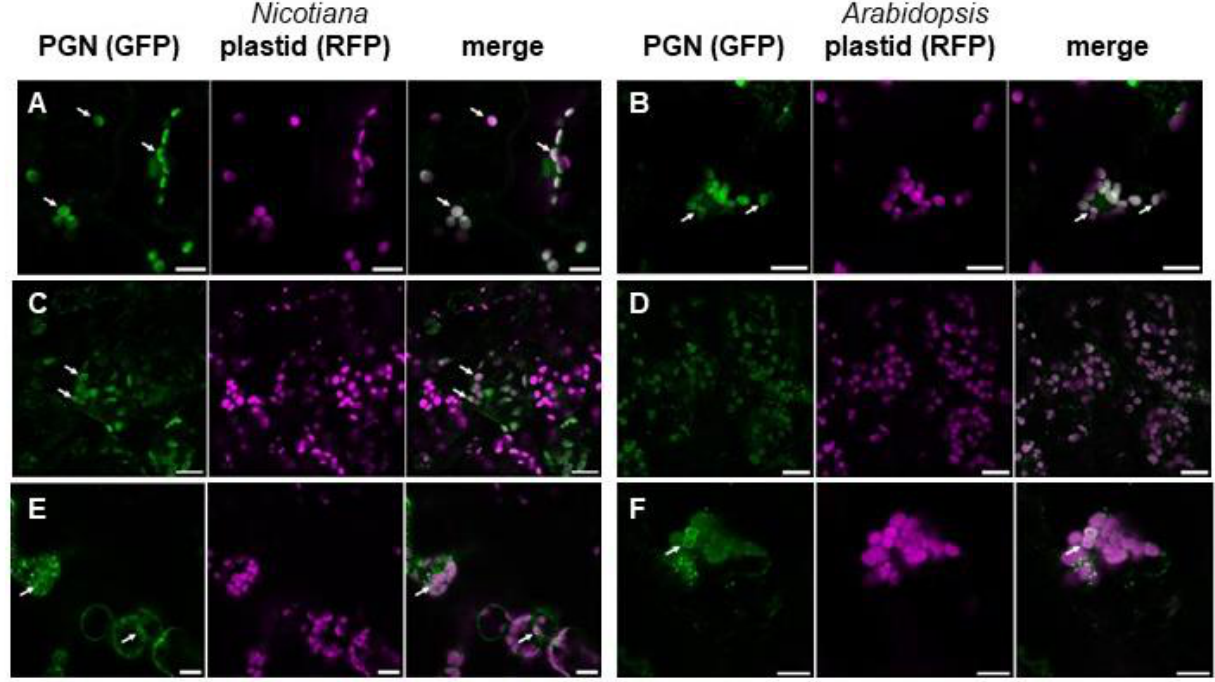
Figure 3. PGN-recognizing proteins localize in and around chloroplasts of Nicotiana and Arabidopsis cells. a-b, Fluorescence microscopic image of Nicotiana cells expressing ( A ) DmPGRP ΔSP -GFP and ( B ) HsPGRP ΔSP -GFP (green) together with a plastid marker (magenta; scale bars 15 µm). ( C , D ) Fluores- cence microscopic image of Arabidopsis cells expressing ( C ) DmPGRP ΔSP -GFP and ( D ) HsPGRP ΔSP - GFP (green) together with a plastid marker (magenta; scale bars 20 µm). ( E , F ) Fluorescence micro- scopic image of ( E ) Nicotiana (scale bar 15 µm) and ( F ) Arabidopsis cells (scale bar 10 µm) transiently expressing AmiC AMIN -GFP (green) together with a plastid marker (magenta). The first picture in a series of three pictures is always the PGN detecting protein fused to GFP (PGN (GFP)), the second one the plastid marker fused to RFP (plastid (RFP)), and the third one represents the merged image. White arrows indicate chloroplasts surrounded by fluorescent ring-like structures.